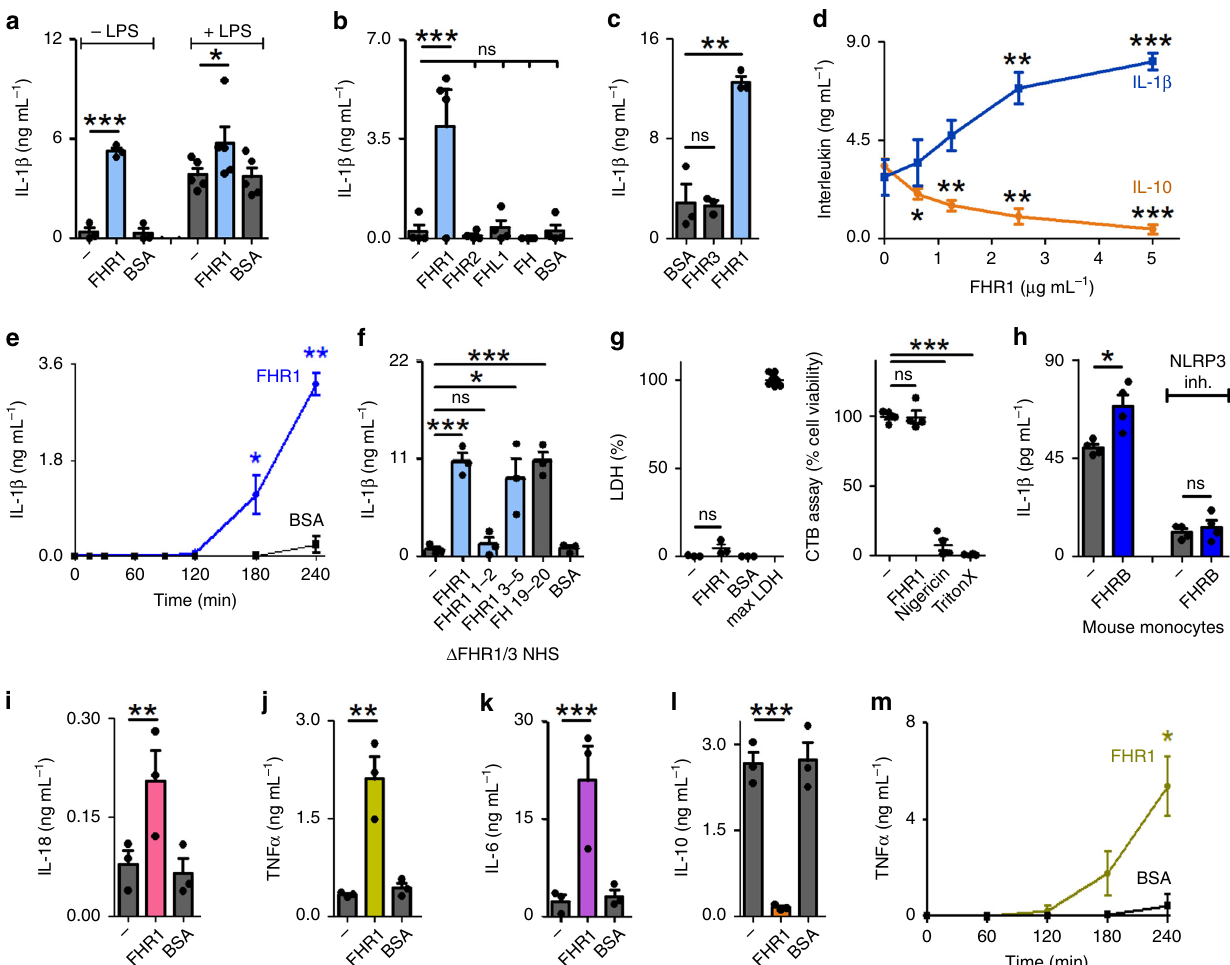
Fig. 1 FHR1 induces in fl ammation. a Immobilized FHR1 induces IL-1 β secretion by monocytes and increases IL-1 β production by LPS-stimulated monocytes in the presence of NHS. b , c In contrast, FHR2, FHR3, FHL-1, FH, and BSA fail to induce IL-1 β secretion. d Immobilized FHR1 reduces IL-10 secretion and increases IL-1 β secretion by LPS-stimulated monocytes in a dose-dependent manner. e Immobilized FHR1 triggers IL-1 β release from monocytes as early as 3 h after the start of incubation. f FHR1 SCR3-5 and FH SCR19-20, but not FHR1 SCR1-2, trigger IL-1 β release by monocytes exposed to Δ FHR1/3 NHS. g Monocytes remain healthy after incubation with FHR1, as demonstrated by very low release of LDH (left) and full cell viability (right). Maximum LDH release (maxLDH) was measured after lysis of cells and lost viability with Nigericin sodium salt or Triton X-100 treatment via cell titer blue (CTB) assay. h FHRB induces IL-1 β release by mouse monocytes exposed to mouse serum. Treatment with NLRP3 inhibitor (MCC950) inhibits FHRB-induced IL-1 β release. i Immobilized FHR1 induces secretion of IL-18, j TNF α and k IL-6, and l reduces IL-10. m Immobilized FHR1 triggers release of TNF α from monocytes as early as 3 h after incubation. Data in a – m represent the mean ± SEM. of three to fi ve independent experiments with different donor cells. * p ≤ 0.05, ** p ≤